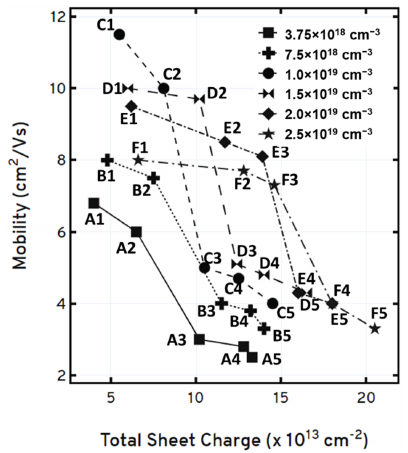
Figure 4. Room-temperature Hall measurement results for samples presented in this work. This figure shows the measured hole mobility as the AlN layer thickness is varied for the different Mg doping levels used at each AlN thickness.